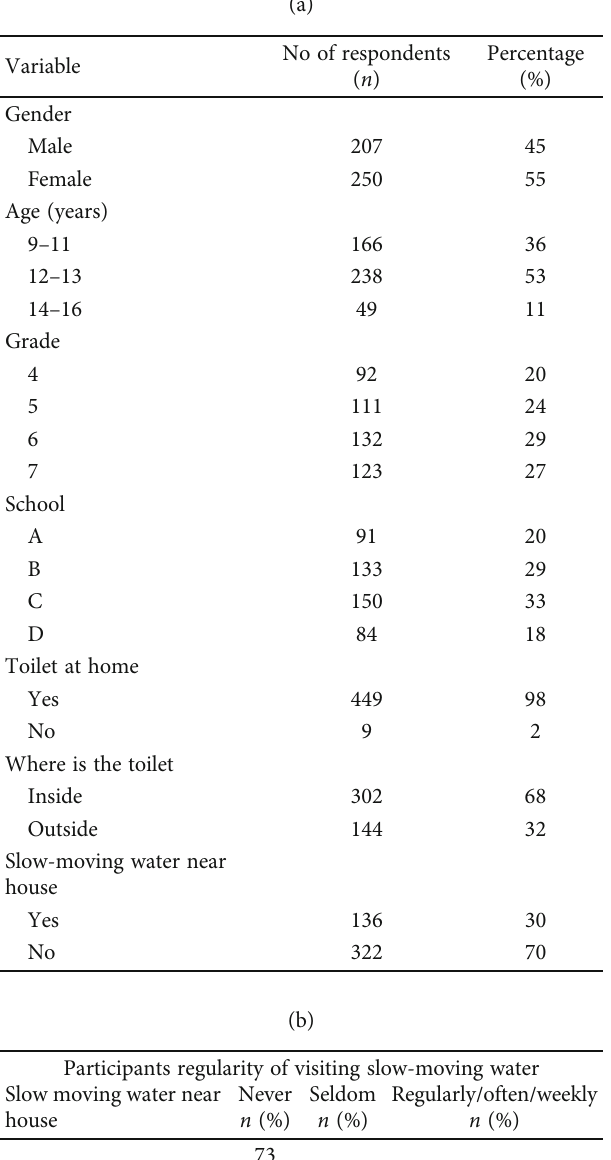
Table 1: Demographic and associated environmental factors among study participants ( n = 458 ).